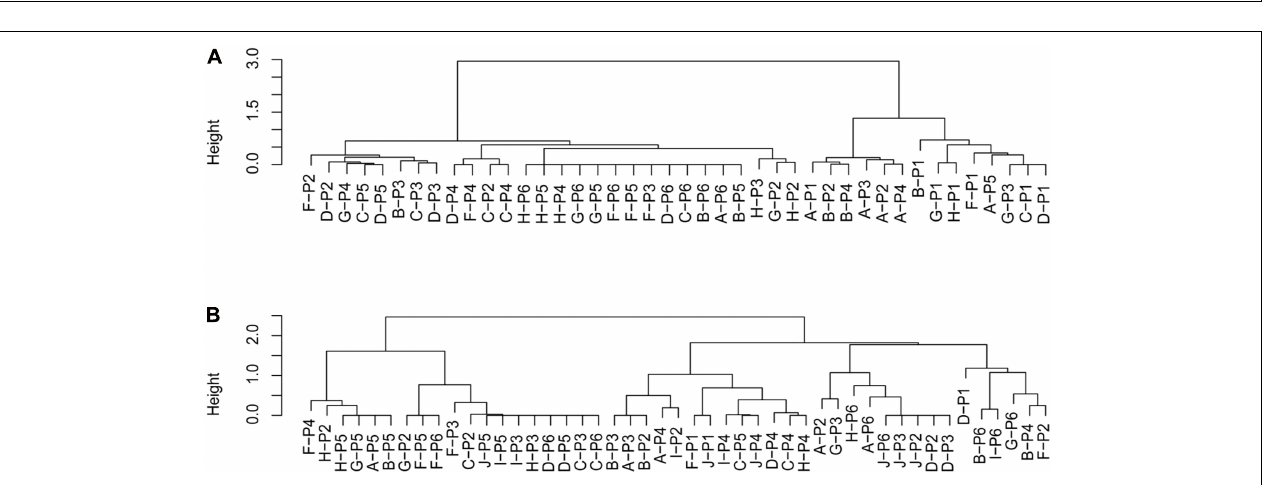
FIGURE 2 | Comparison of assemblage of actions before and after the spatial alteration. The data for mound and track areas were not available before the alteration.